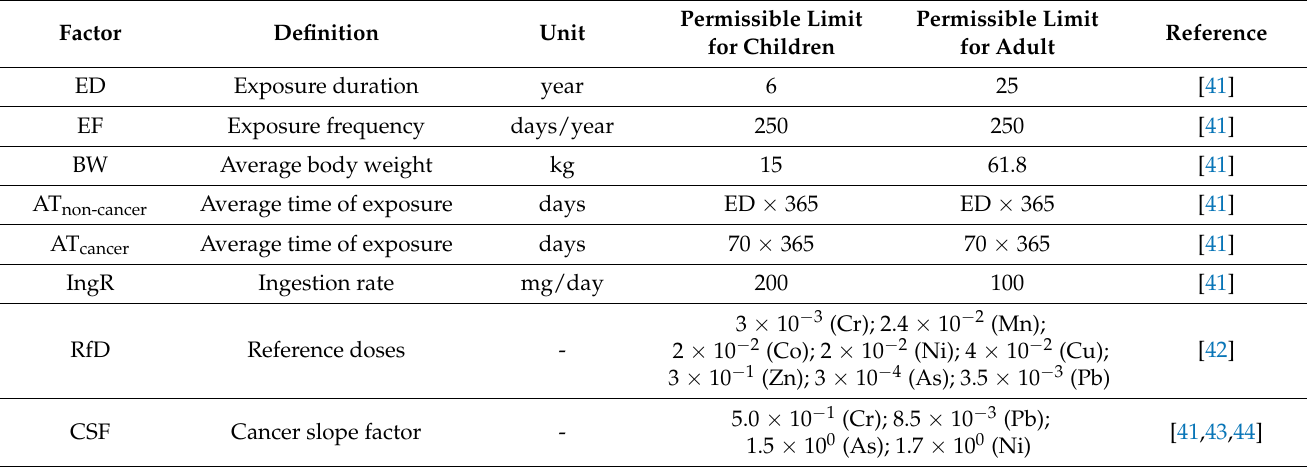
Table 1. Parameter definitions and values used in the human health risk